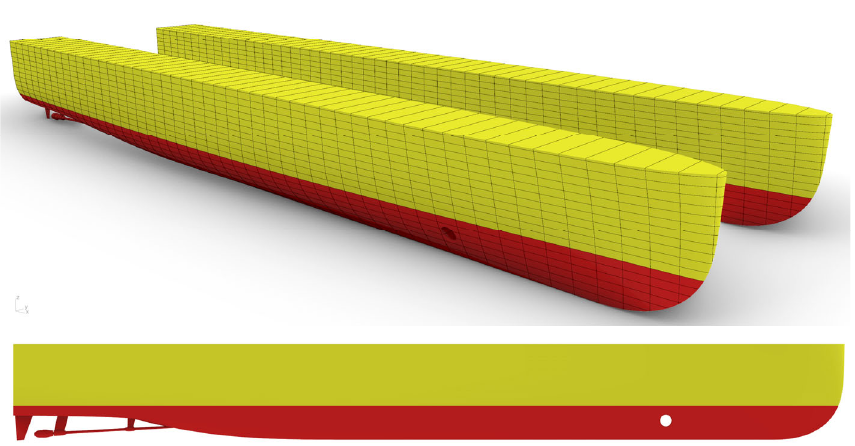
Figure 1. The Stavanger Demonstrator of the H2020 TrAM Project: MS Medstraum.